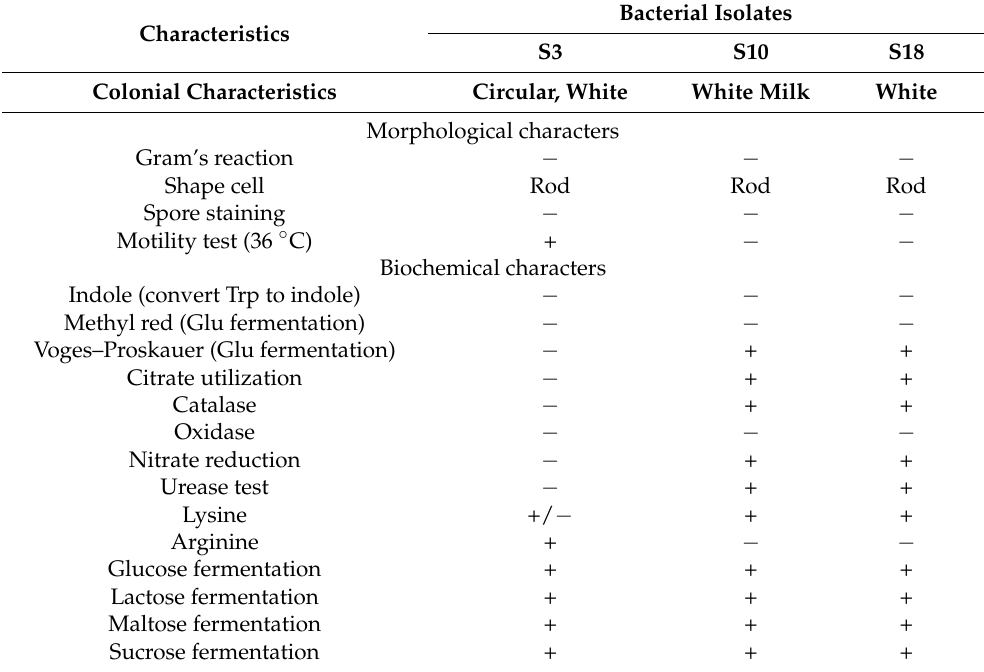
Table 3. Preliminary identification of bacterial isolate by conventional microbiological methods.